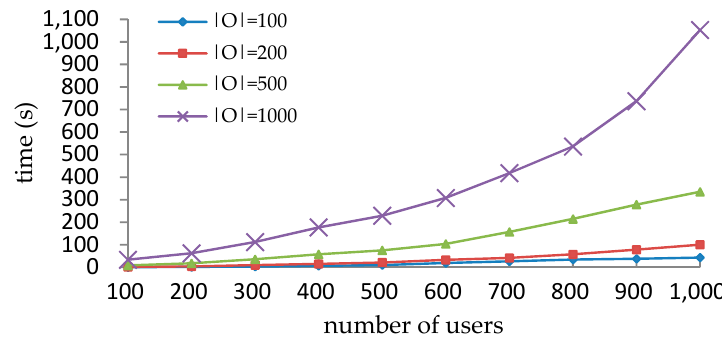
Figure 3. Comparison of rules for different numbers of users and objects.